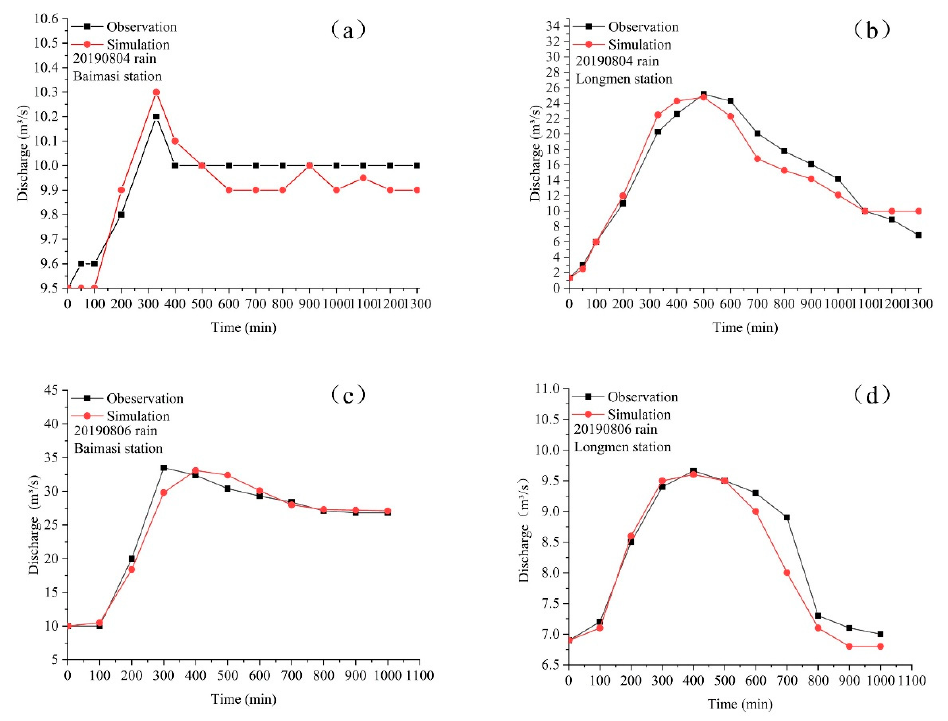
Figure 8. Comparison of simulated discharge and observed discharge of Storm 1 and Storm 2: ( a ) Discharge calibration of 20190804 rain in Baimasi station; ( b ) Discharge calibration of 20190804 rain in Longmen station; ( c ) Discharge evaluation of 20190806 rain in Baimasi station; ( d ) Discharge evaluation of 20190806 rain in Longmen station.